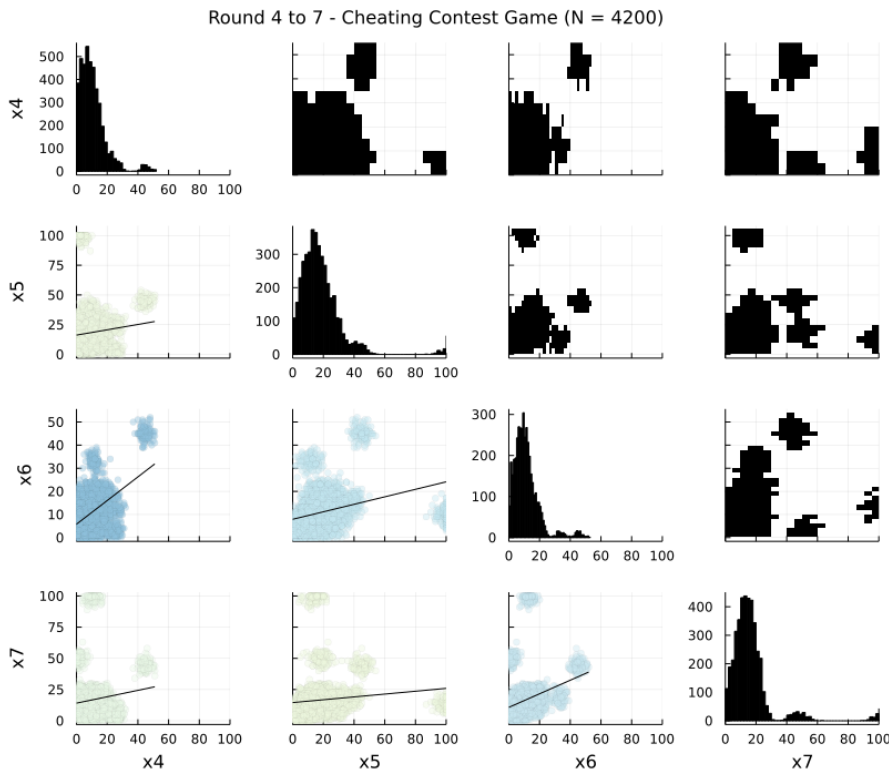
Figure A3. Correlation plot rounds IV to VII N =